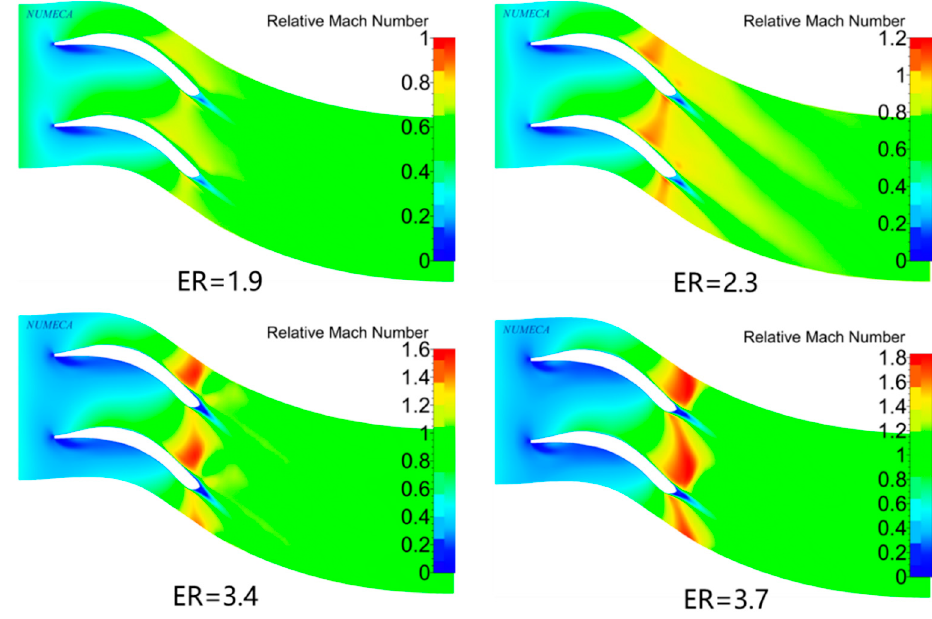
Figure 7. The distribution of relative Mach number at different expansion ratios.